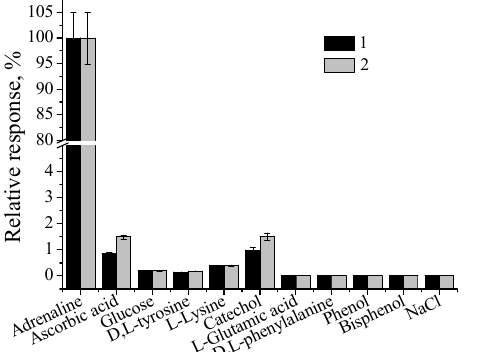
Figure 6. Selectivity for nAuCePt/GE. The test was performed with 2 mM (1) and 4 mM (2) solutions of different analytes under the working potential of − 50 mV. The amperometric signal on AD being the highest was chosen as